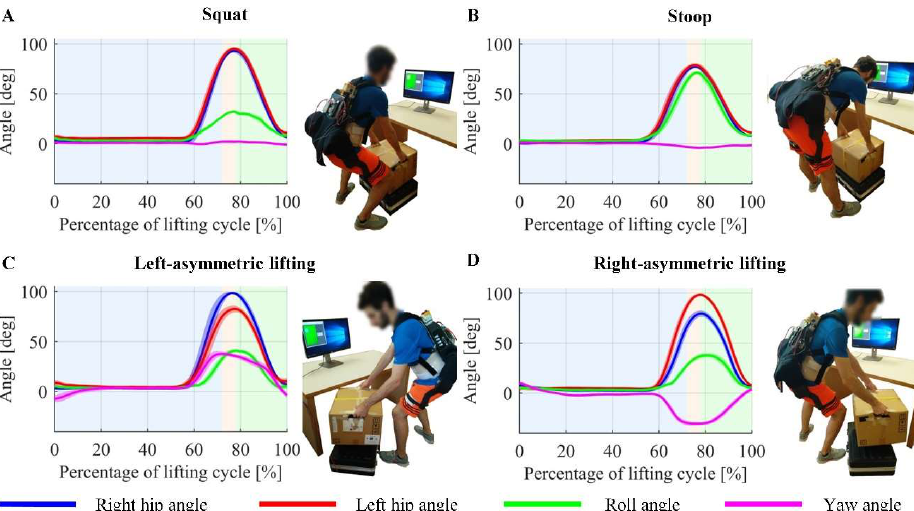
Figure 3. ( A – D ) Sensor signals of squat, stoop, left-asymmetric and right-asymmetric lifting over the lifting cycle for a representative subject. The figures were plotted using the data for lifting the load and placing it on the table, which were collected in Session 1 of the experiment. Solid curves and shaded regions denote mean values and standard deviations of corresponding angles over multiple cycles, respectively. The three classification outputs are denoted by backgrounds of different colors: Other (blue), Pre-extension (yellow) and Extension (green). Left and right hip angles are measured by exoskeleton’s hip joint encoders, and roll and yaw angles are estimated using raw signals collected by the IMU on exoskeleton’s backpack.